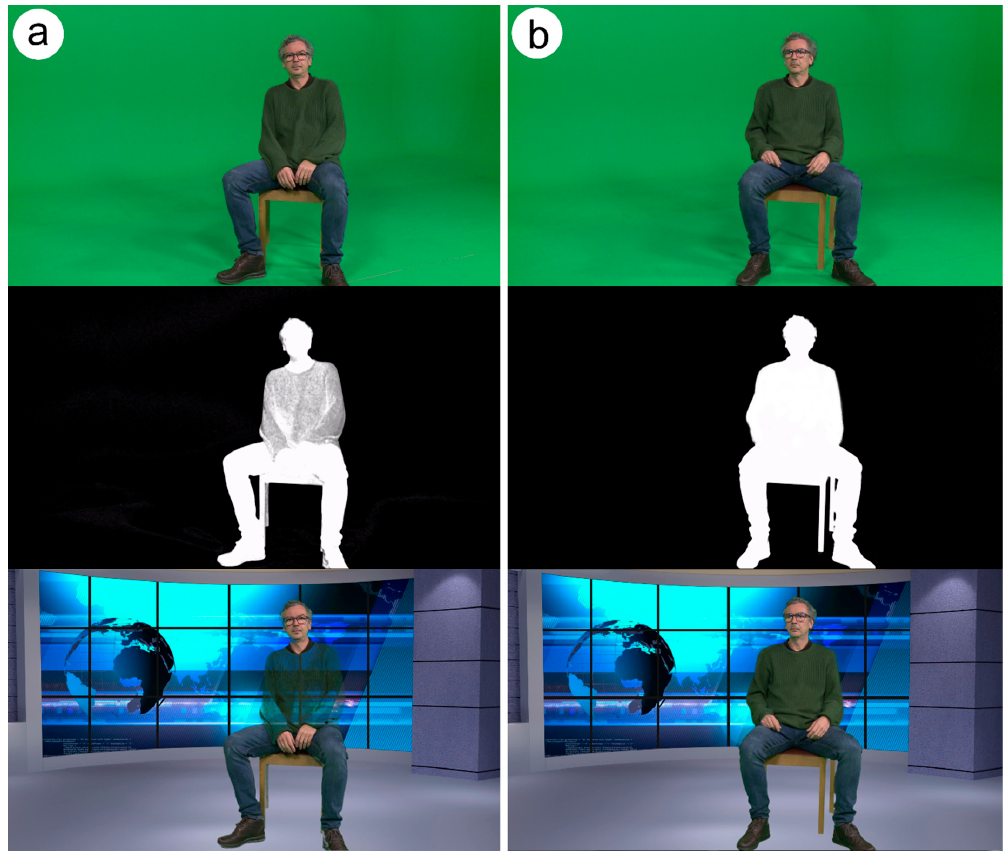
Figure 2. Chroma-keying process. Original images ( top ), chroma-keying mask ( middle ) and final composite image ( bottom ). Incorrect keying threshold configuration result ( a ). Proper chroma-keying configuration result ( b ).